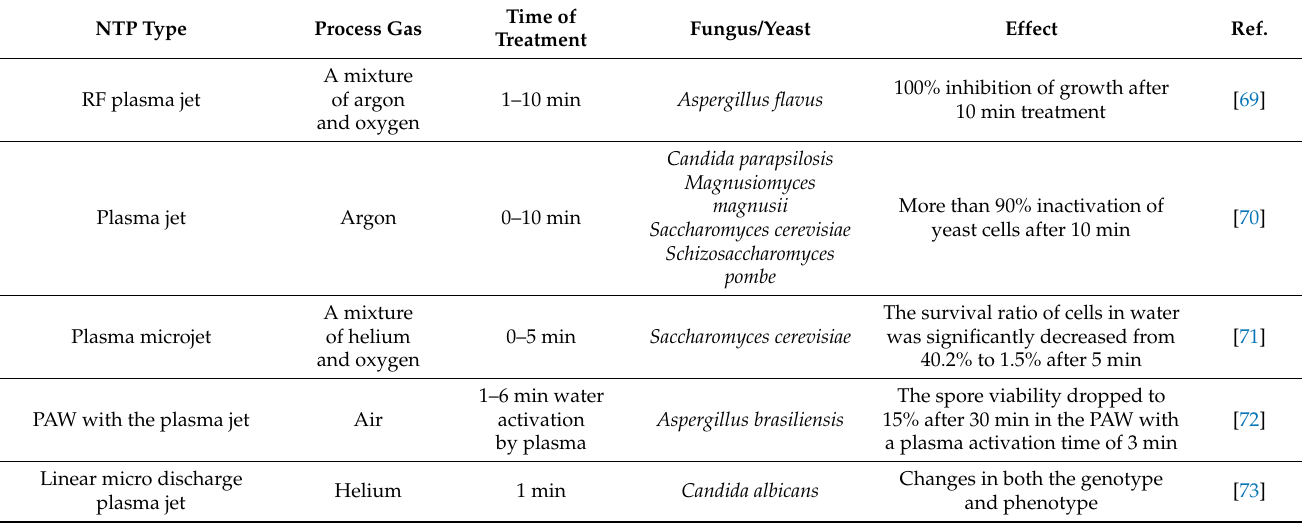
Table 1. Studies about fungal inactivation, growth inhibition, and biofilm